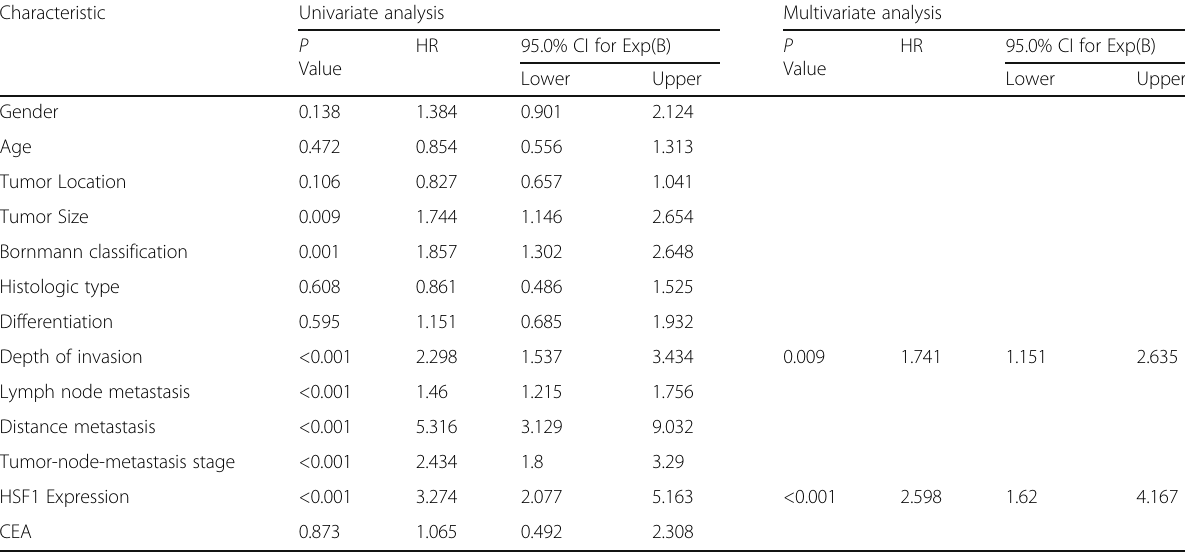
Table 2 Cox proportional-hazard regression analysis for Overall Survival